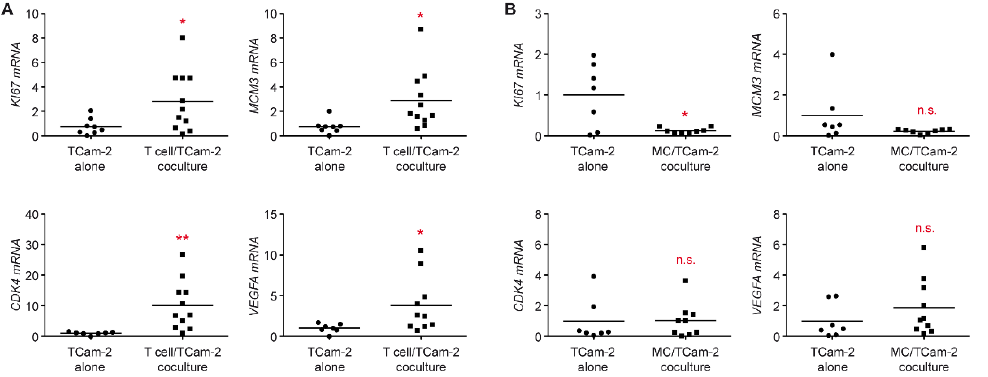
Figure 7. Analysis of gene expression of markers for proliferation and the metastatic potential in TCam-2 cell cocultures with immune cells. T cells or monocytes (MCs) were isolated from PBMC of healthy blood donors using magnetic cell sorting and cultured in 6-well plates on a monolayer of TCam-2 cells for 24 h. TCam-2 cells cultured alone served as a control. TCam-2 cells were collected from both cultures and RNA was prepared for subsequent analysis by quantitative RT-PCR. Relative mRNA levels of KI67 , MCM3 , CDK4, and VEGFA in TCam-2 cells collected from T cell cocultures ( A ), MC cocultures ( B ), or TCam-2 cells cultured alone are depicted as dot plots with a horizontal line representing the mean. Gene expression was calculated by normalization to the housekeeping gene 18SRNA , mRNA levels in TCam-2 cells cultured alone were arbitrarily set to 1. N = 7–10; PBMC were obtained from 5–6 healthy volunteers (T cell cocultures); N = 7–8; PBMC were obtained from 4–5 healthy volunteers (MC cocultures). Statistical analysis was performed by unpaired t -test (*: p < 0.05; **: p < 0.01; n.s.: p > 0.05).